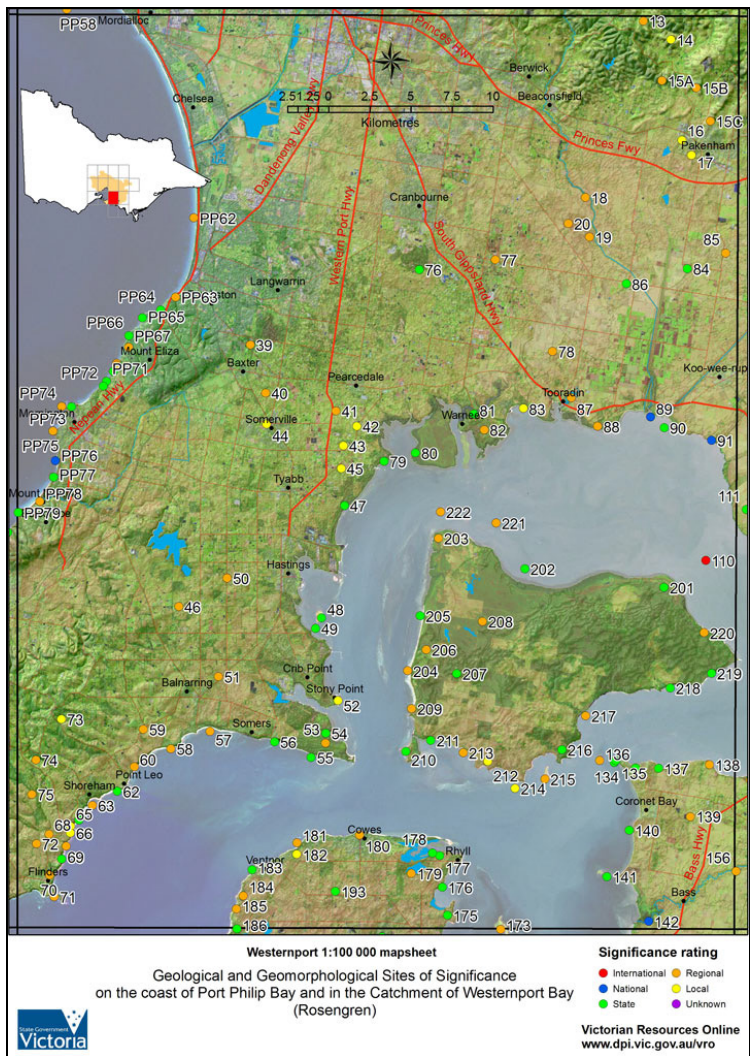
Figure 8. 1:100,000 map sheet showing locations of Sites of Geological and Geomorphological Significance that can be clicked to reveal information derived from the original report.  State of Victoria, Department of Primary Industries 1997 Reproduced with